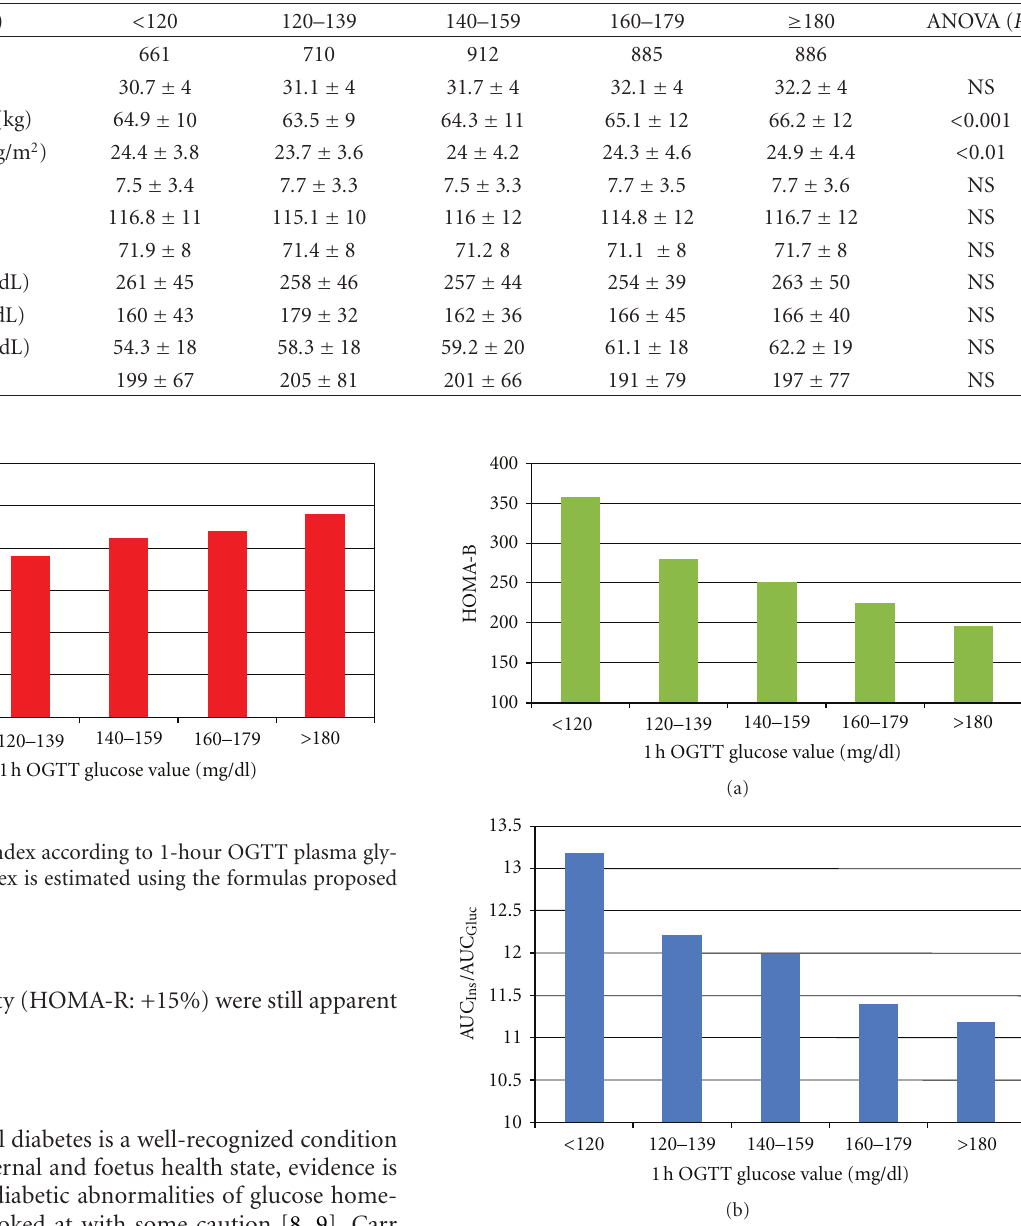
Table 1: Clinical features of pregnant women related to 1-hour glucose values during OGTT (data are means ± SD).